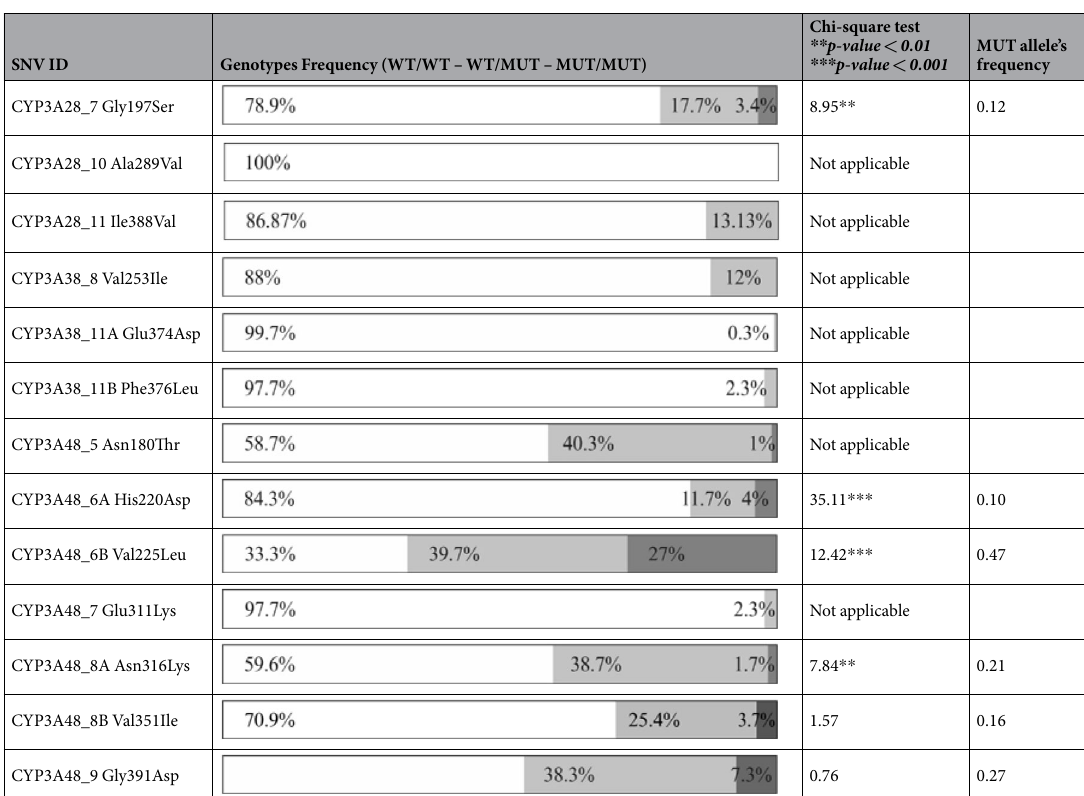
SNV ID Genotypes Frequency (WT/WT – WT/MUT – MUT/MUT)